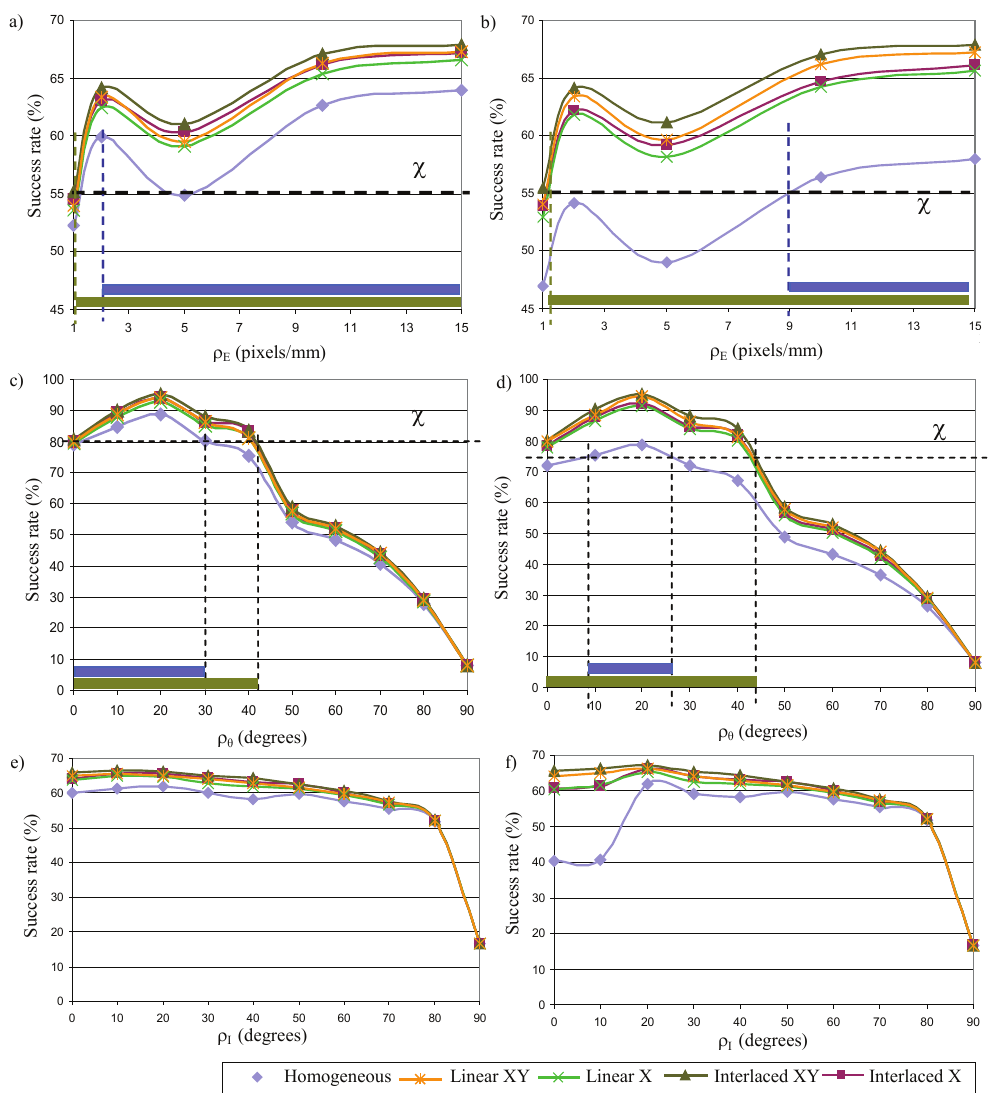
Figure 13. Success rates for the dielectric ( a , c , e ) and metallic ( b , d , f ) material according to scale ( a , b ), angle ( c , d ) and intensity lighting ( e , f